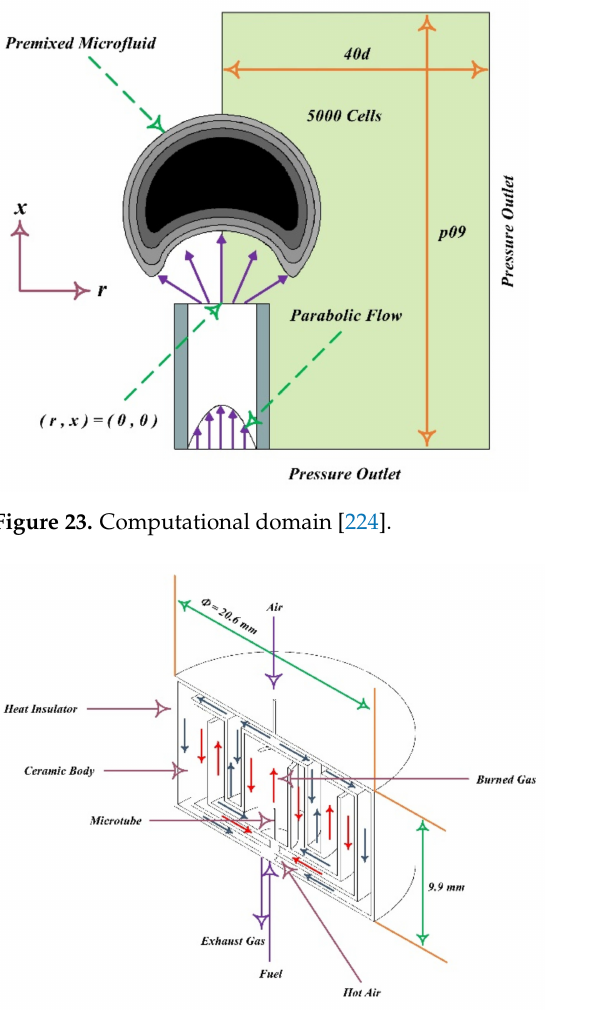
Figure 24. Conceptual design of a heat-recirculated combustor for micropower generation